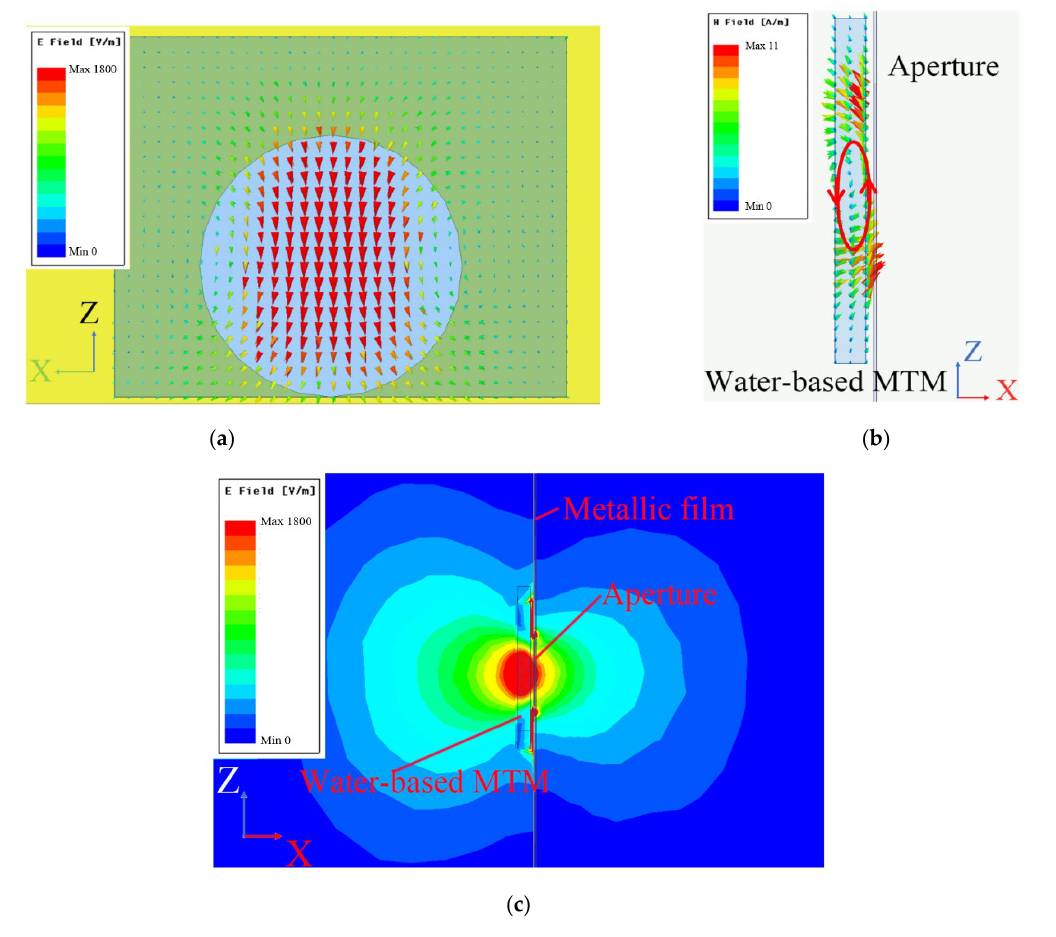
Figure 3. ( a ) The electric field and ( b ) the magnetic field vector in the water. ( c ) The electric field distribution in the waveguide.